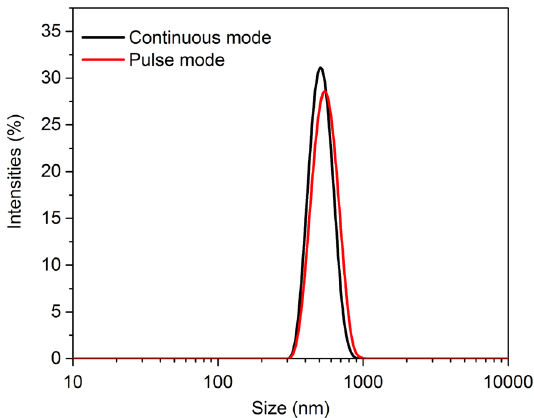
Figure 5: TG curves of BSA/AM microcapsules at di ff erent ultrasound amplitudes.